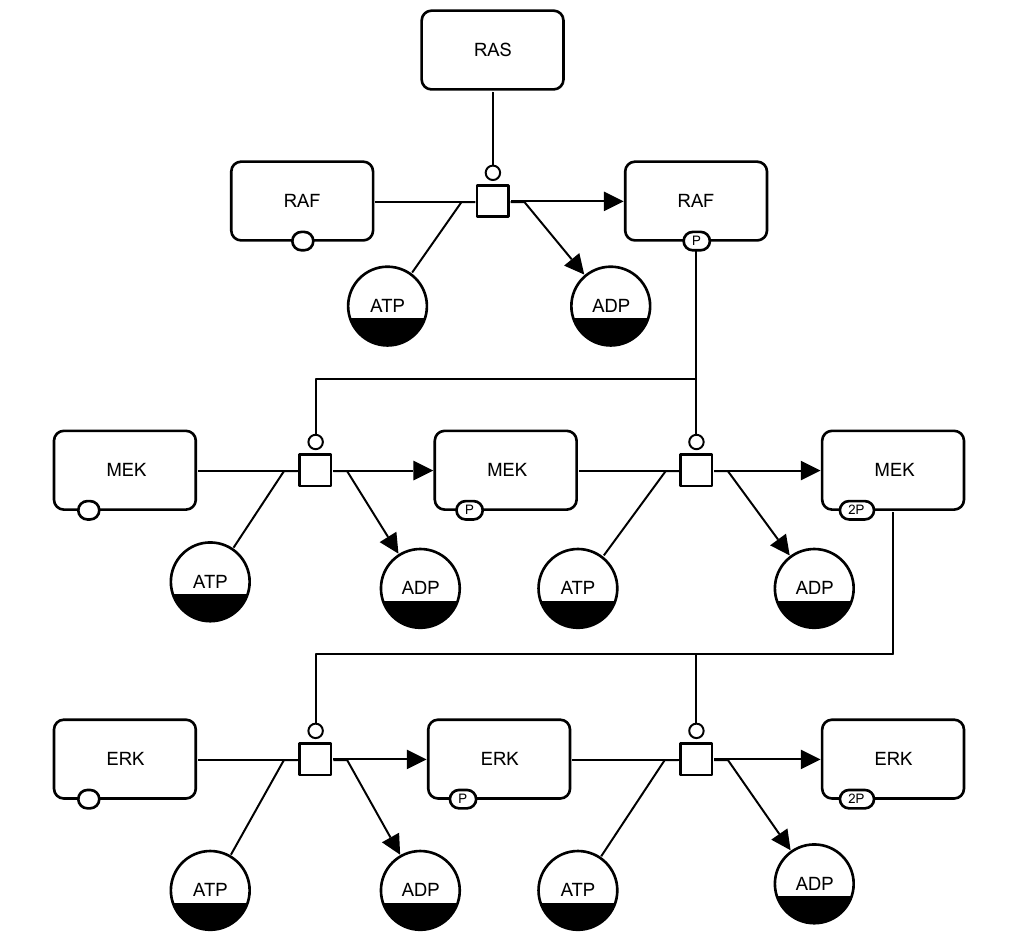
Figure 2.1: This example of a Process Description map uses two kinds of entity pool nodes: one for pools of different macromolecules (Section 2.4.3) and another for pools of simple chemicals (Section 2.4.2). Most macromolecule nodes in this map are adorned with state variables (Section 2.3.2) representing phosphorylation states. This map uses one type of process node , the process node (Section 2.6.1), and three kinds of connecting arc, consump- tion (Section 2.7.1), production (Section 2.7.2) and catalysis (Section 2.8.3). Finally, some entity pool nodes have dark bands along their bottoms; these are clone markers (Sec- tion 2.3.3) indicating that the same pool nodes appear multiple times in the